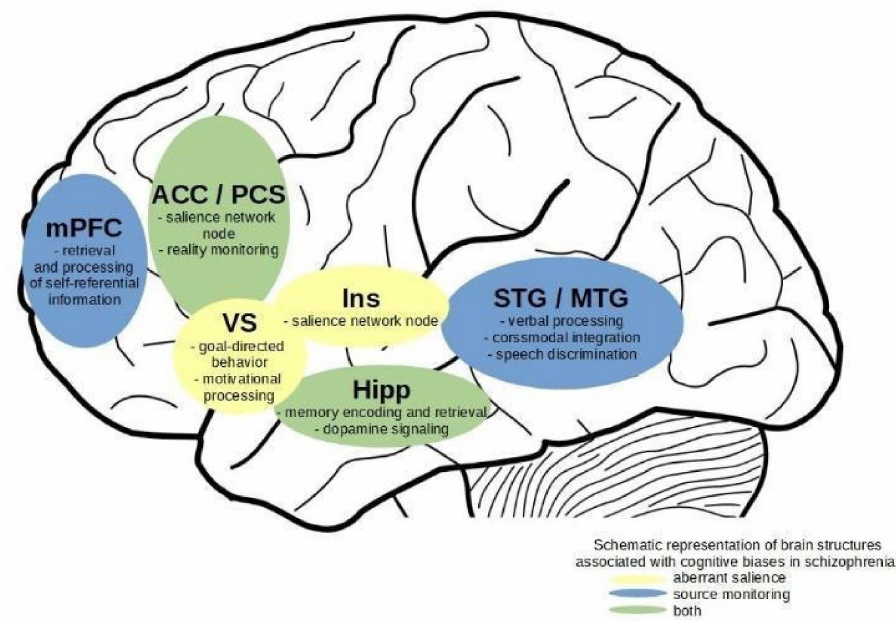
Figure 2. Schematic representation of brain regions with effects detected between schizophrenia patients and non-clinical controls in fMRI studies of aberrant salience and source monitoring. For display purposes, effects are presented only on the left hemisphere of the brain. mPFC—medial prefrontal cortex, ACC/PCS—anterior cingulate cortex and paracingulate sulcus, vs.—central striatum, Ins—insula, Hipp—hippocampus, STG/MTG—superior and middle temporal